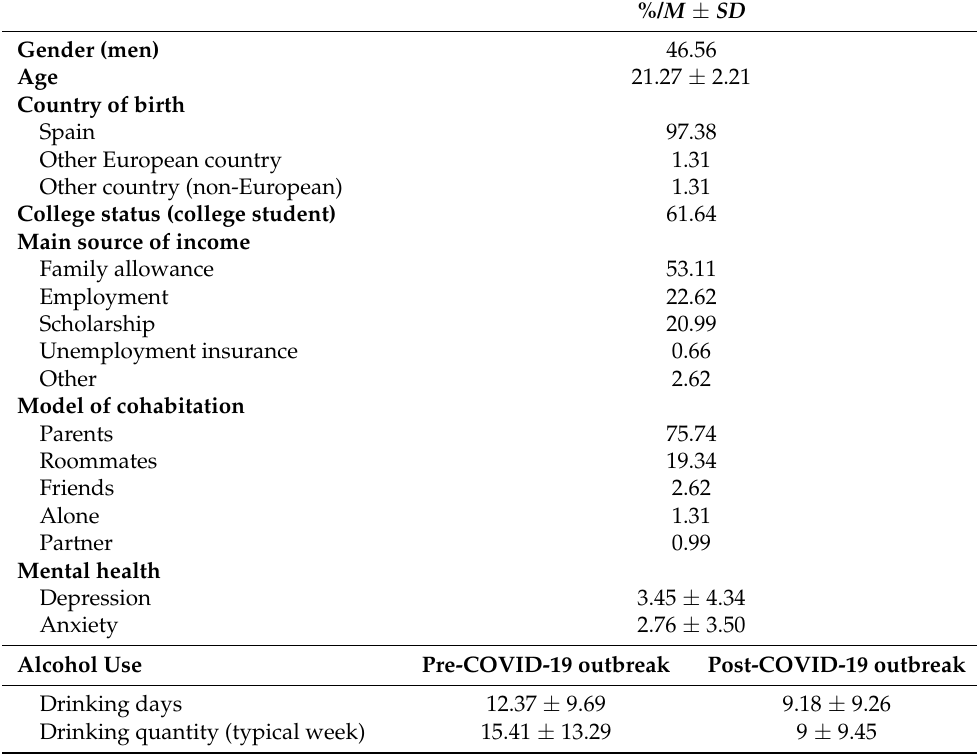
Table 1. Sample characteristics.